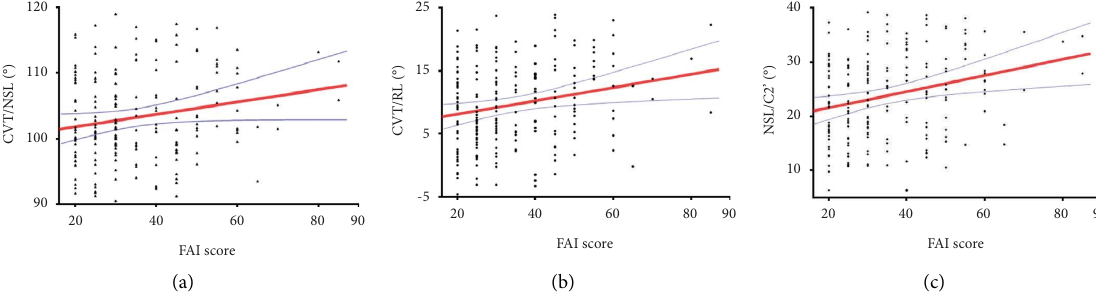
Figure 2: Scatterplot for the correlations between the FAI score and (a) CVT/NSL, (b) CVT/RL, and (c) NSL/C2’ in overall patients. Scatterplot is ftted with the regression line (red line). Te blue bands represent the 95% confdence interval. Table 7: Multivariate linear regression analysis between the possibility of presenting TMJ pain and head and cervical posture parameters, adjusted for gender, age, educational level, residence, and family per capita monthly income. Head